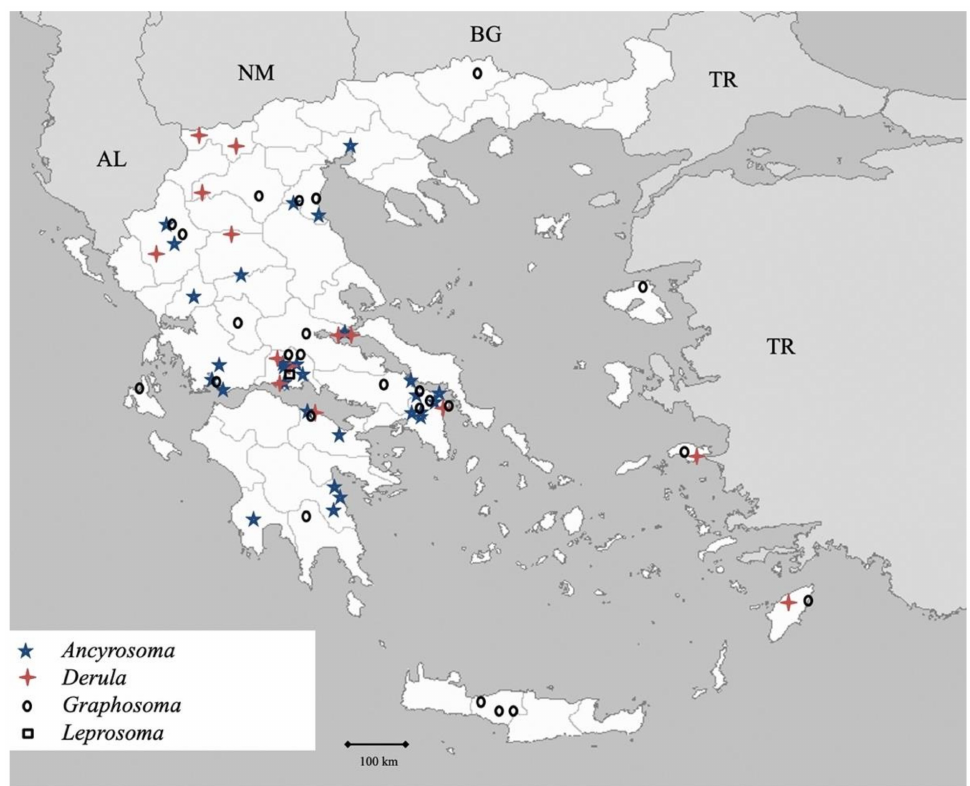
Figure 16. Map showing collecting sites of species of genera Ancyrosoma, Derula, Graphosoma and Leprosoma during the present study in